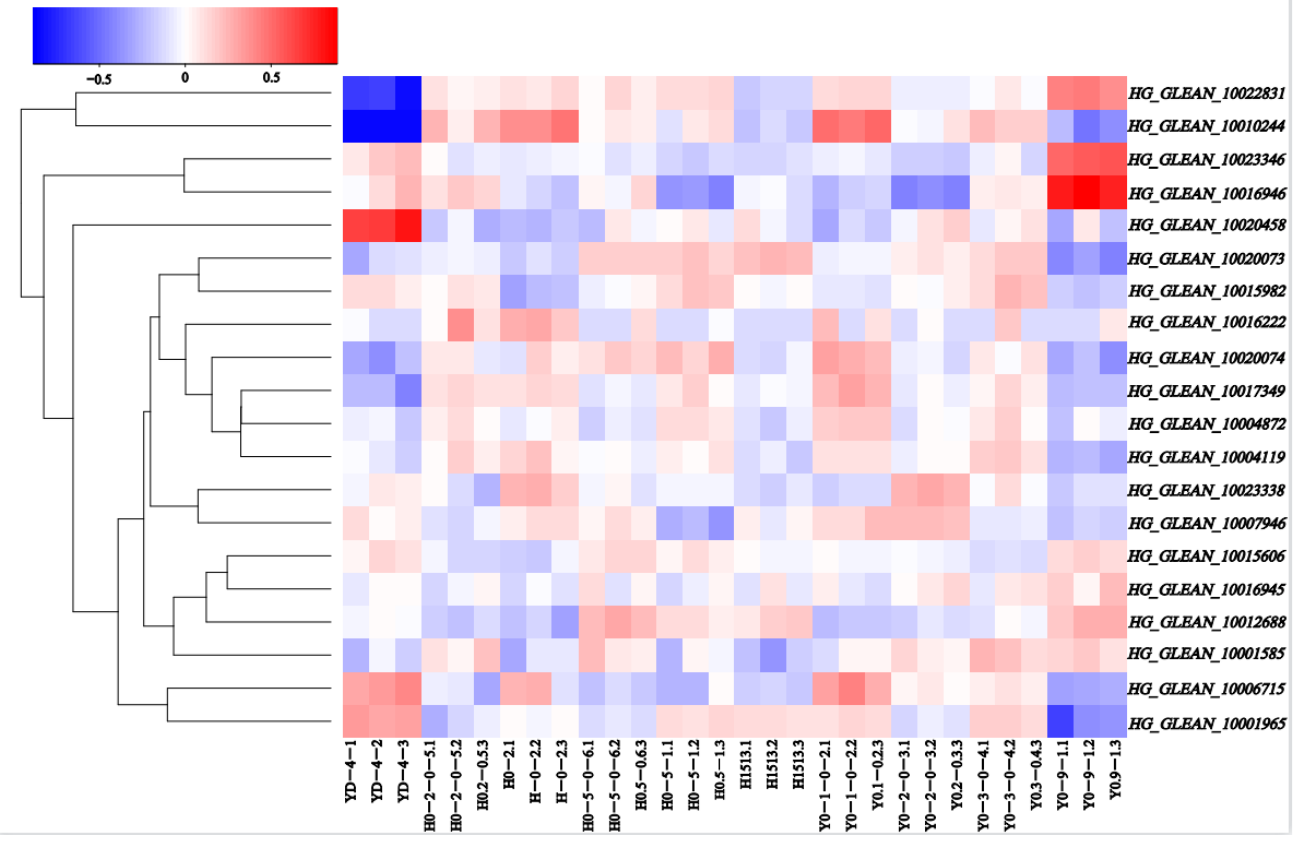
Figure 4. OVATE gene family members expression profiles in the ovaries of bottle gourd. Blue or red indicates lower or higher levels of expression, respectively, of each transcript in each sample.